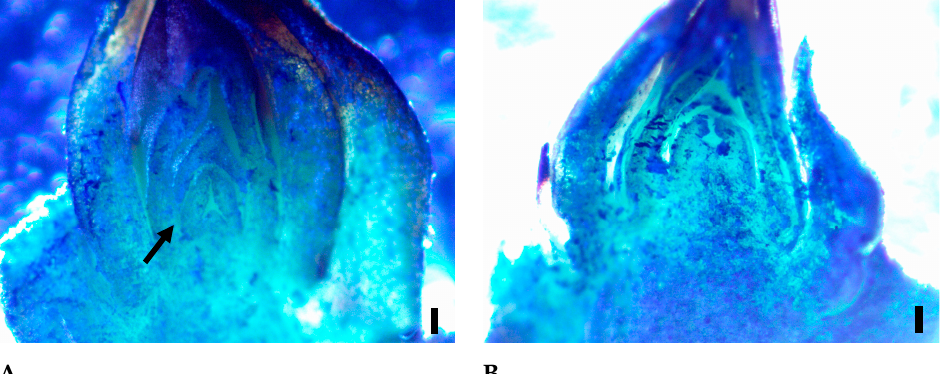
Figure 9. The two transition leaves are visible (arrow) with a dome-shaped meristematic apex indi- cating the successive evolution towards a flower (( A ), Ki-Zakuro), and a still undifferentiated and flat meristematic apex (( B ), Haku Botan). The bar represents 150